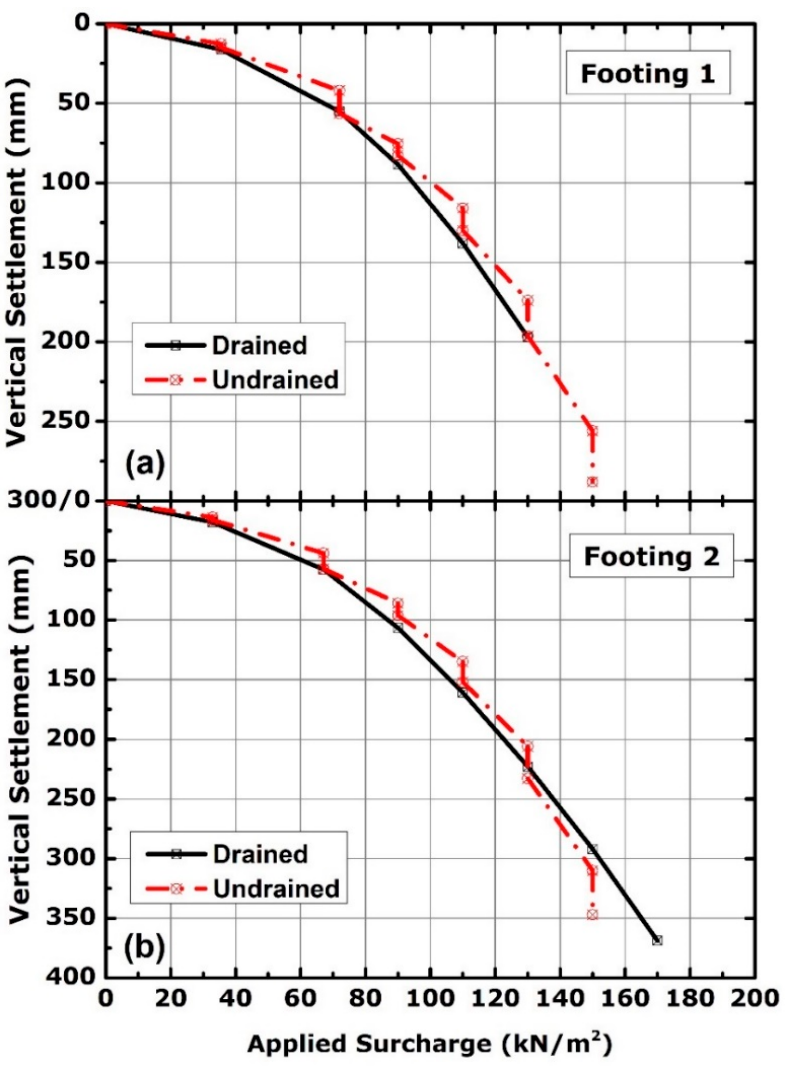
Figure 6. Load-displacement response for ( a ) Footing 1; ( b ) Footing 2.